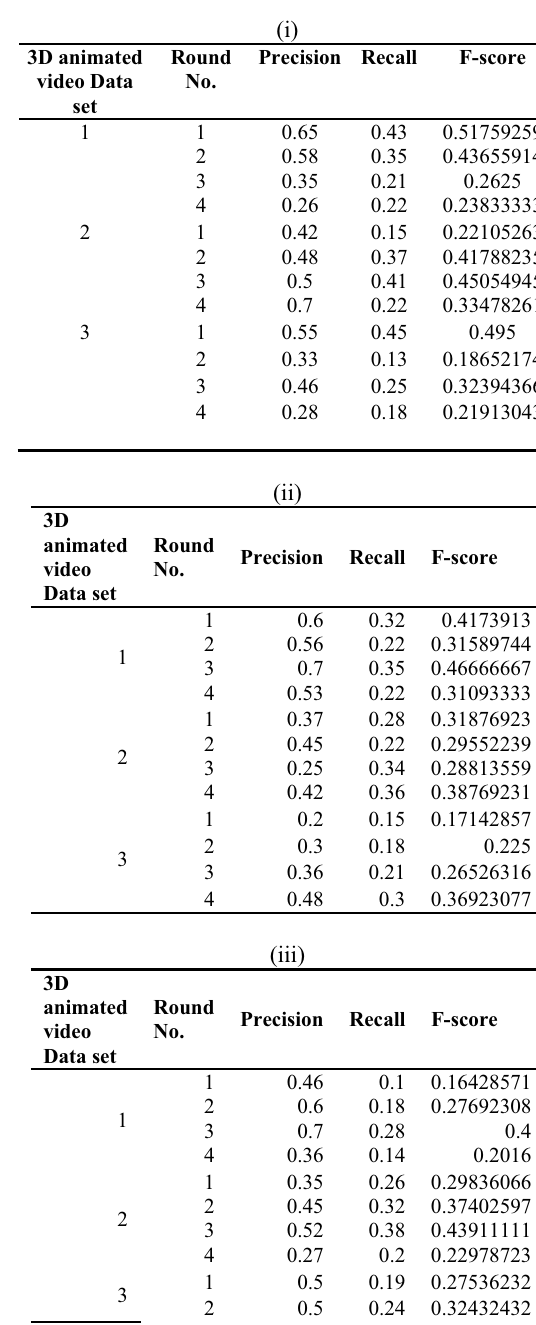
Table. 2. Precision-recall and F-score values for CBVR system (i) with Motion pattern (ii) with motion feature and RGB color model (iii) with histogram features and (iv) with extensive feature set for 3D- animated